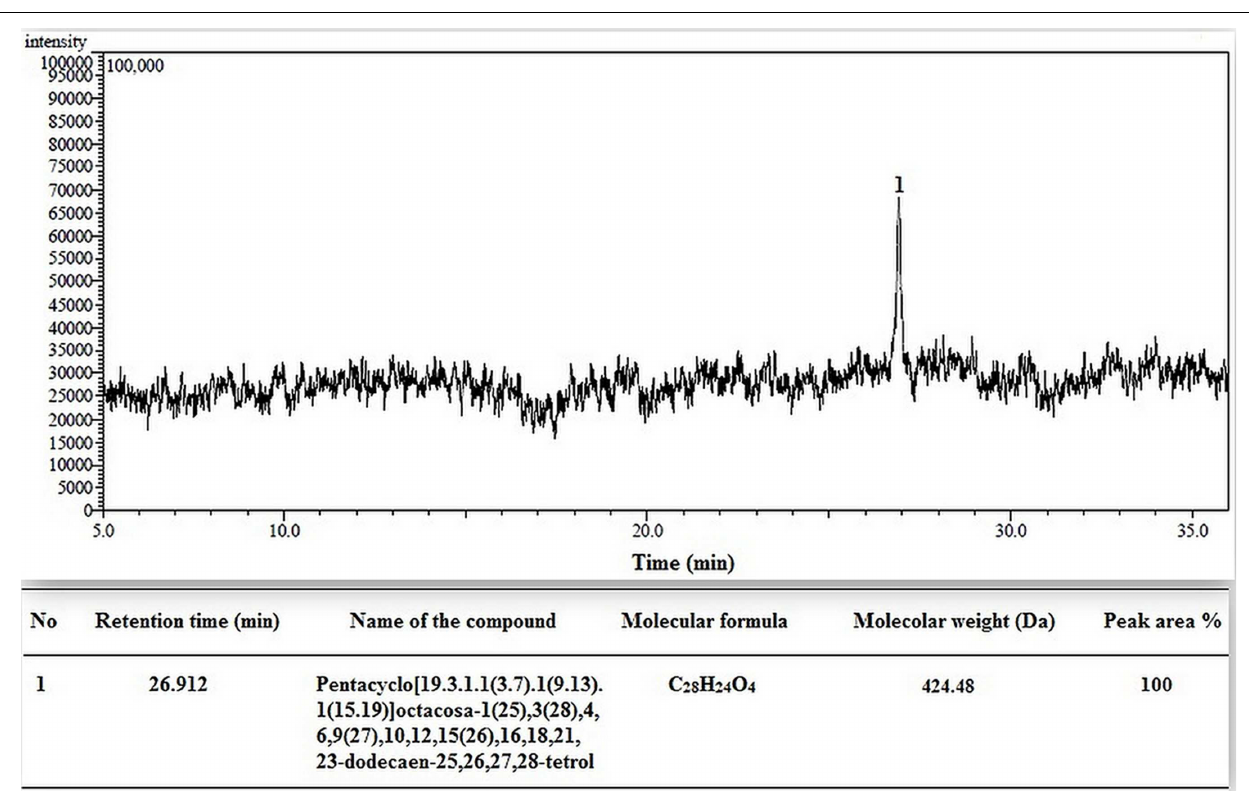
Frontiers in Pharmacology |